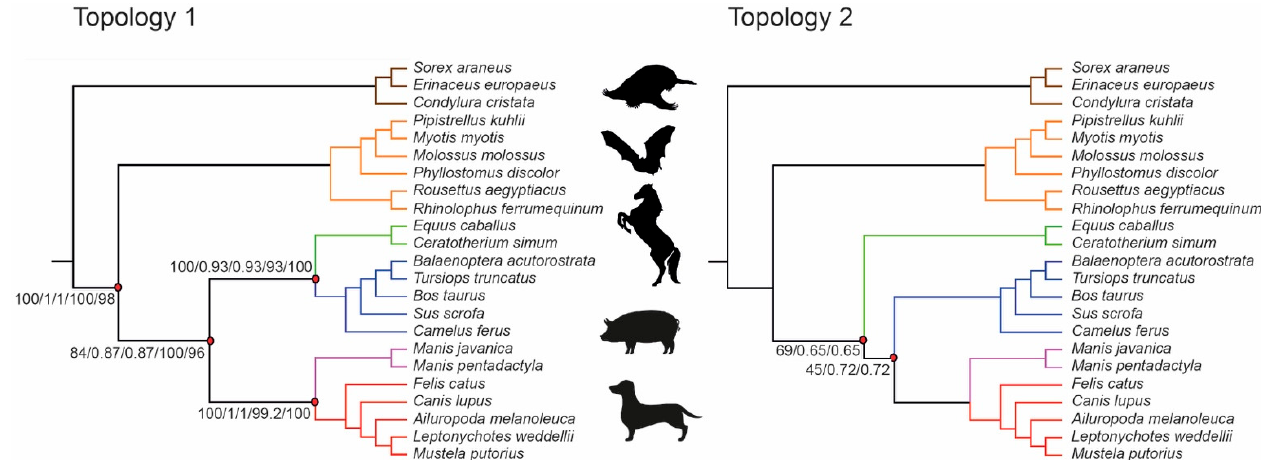
Figure 5. Two laurasiatherian topologies with the highest support revealed by exon data analyses. Support scores for internal edges are displayed only for those edges where at least one dataset provides support < 100% (Topology 1: DNA concatenated ML, DNA coalescence polytomies not collapsed ASTRAL, DNA concatenated SVDquartets, amino acids concatenated ML; Topology 2: DNA (min 500 bp length) concatenated ML, DNA (min 500 bp length) coalescence polytomies not collapsed ASTRAL).